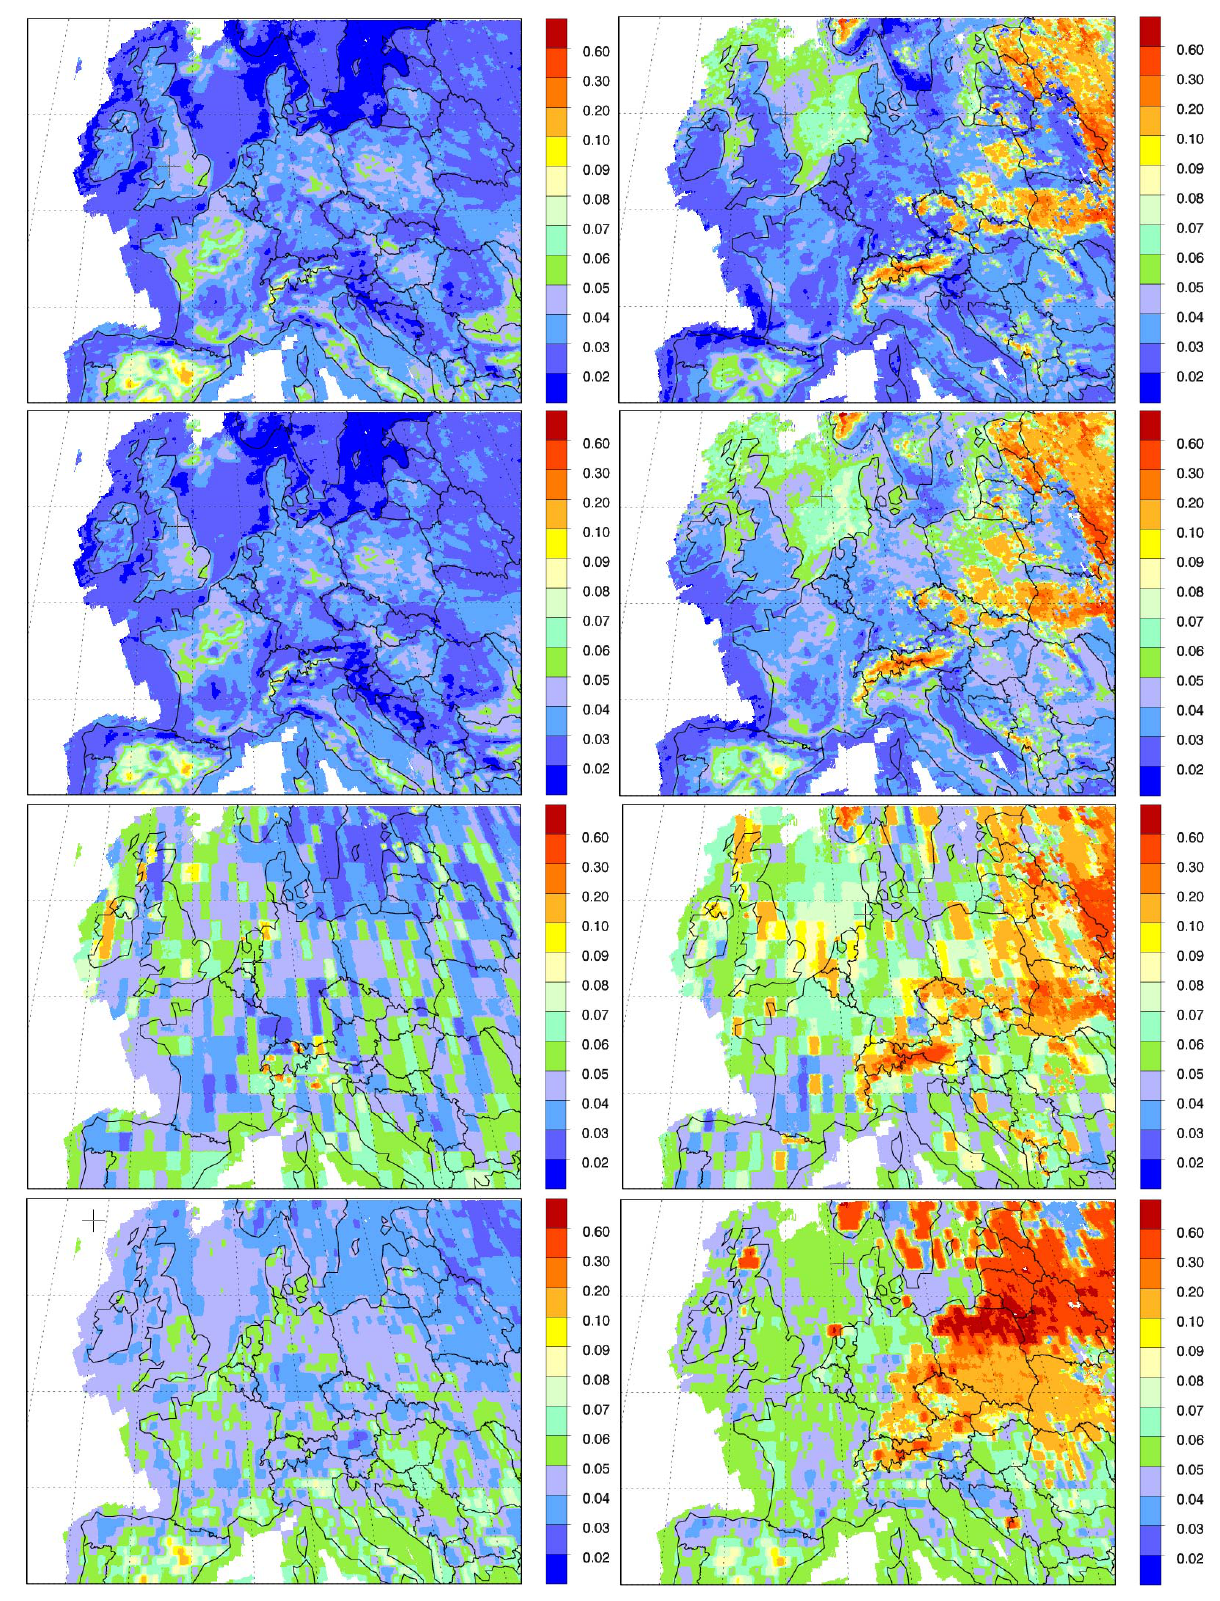
Fig. 11. Comparison between mean BRF (first row), black-sky albedo (second row), TOMS/GOME LER (third row) and OMI LER (fourth row) for July and